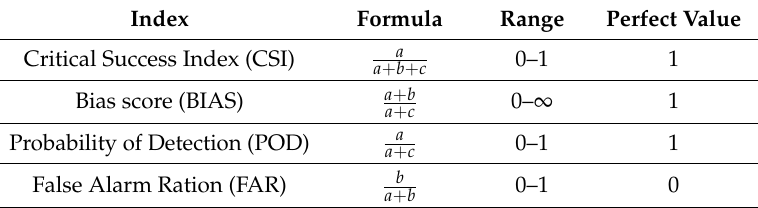
Table 4. Statistical performance measures used for evaluation and